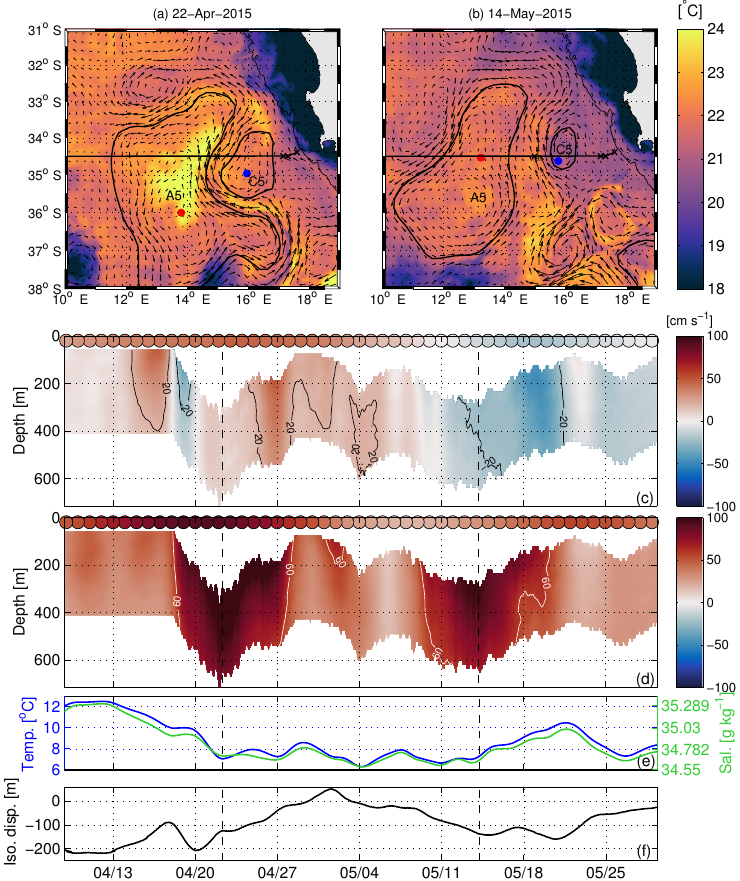
Figure 10. Intrusion water: (a, b) SST satellite images for selected dates (vertical black lines on the time series). Vertical–temporal section of the u component (c) and v component (d) of the current speed measured from the upward-looking ADCP at M4. The colored circles at the top of the section show the u and v component of the current speed from altimetry data. (e) Temporal evolution of temperature (blue line) and salinity (green line) and (f) the isopycnal displacement recorded at the first SBE37 MicroCATs between 435 and 700m